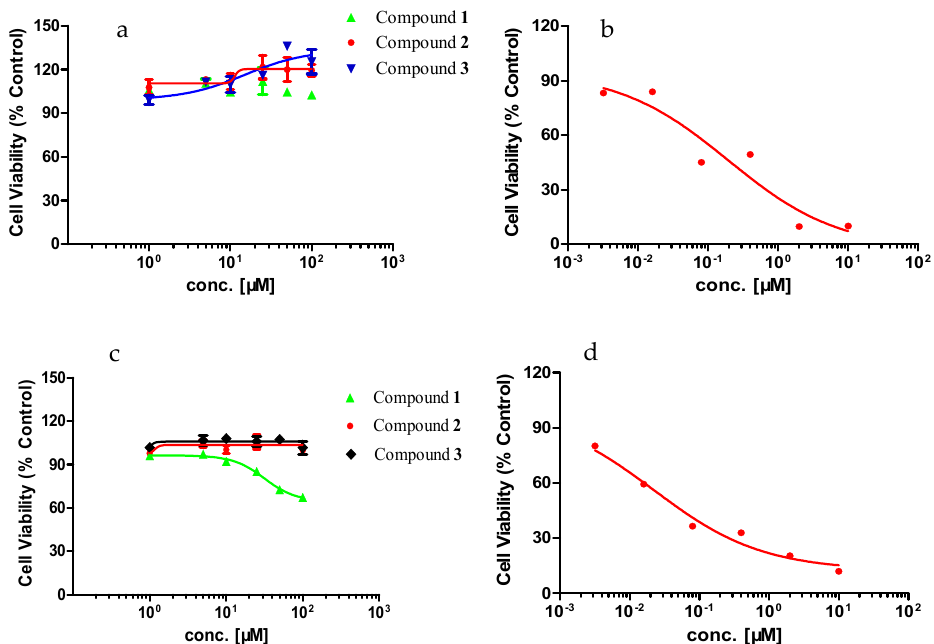
Figure 3. The cell viability of the three compounds in a series of concentrations (5, 10, 25, 50, 100 µ M) and positive drug staurosporine (STSP) on two types of PC-12 cells after exposure for 48 h. ( a ) the three compounds’ concentration responses of poorly di ff erentiated PC-12 cells; ( b ) STSP concentration response in poorly di ff erentiated PC-12 cells; ( c ) the three compounds’ concentration responses in highly di ff erentiated PC-12 cells; ( d ) STSP concentration response in highly di ff erentiated PC-12 cells. Table 2. Cytotoxicity of compounds 1 – 3 against PC12 cell lines (IC 50 , µ M)